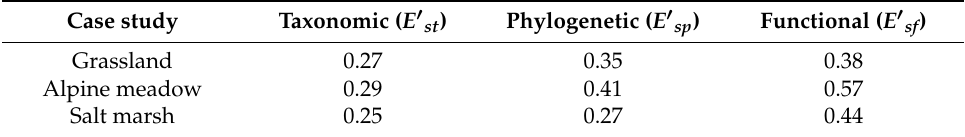
Table 2. Taxonomic, phylogenetic and functional redundancy, as expressed by normalized centroid distances (Equation (15)) from the species-based configuration, in the actual ecological examples.